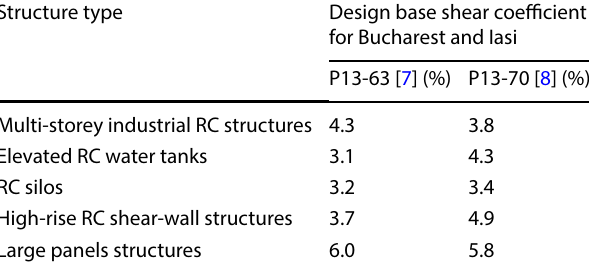
Table 2 Design base shear coefficients for the analysed structures Structure type Design base shear coefficient for Bucharest and